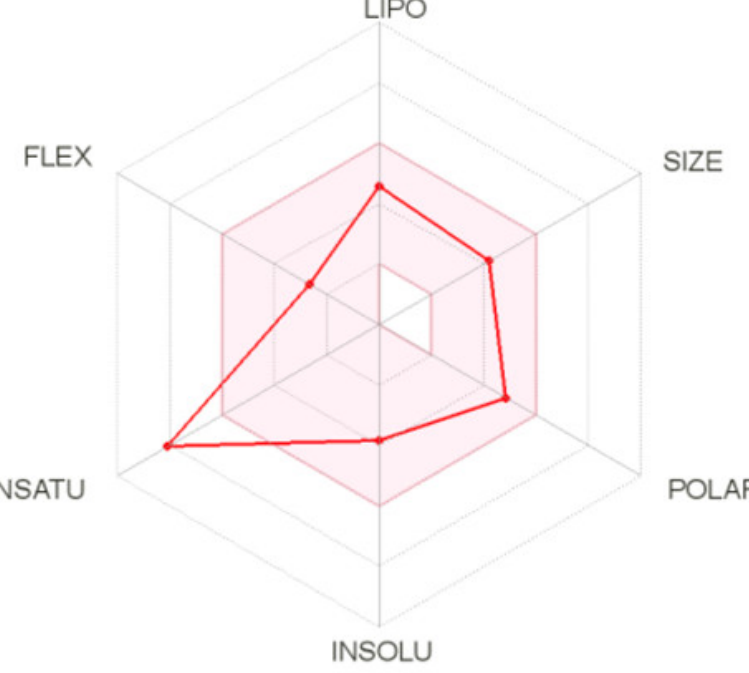
Figure 8. The bioavailability radar (the pink area exhibits the optimal range of a particular prop- erty) for compound 2C (LIPO = lipophilicity as in XLOGP3; SIZE = size as in molecular weight; POLAR = polarity as TPSA (topological polar surface area); INSOLU = insolubility in water by log S scale; INSATU = insaturation per fraction of carbons in the sp3 hybridization; FLEX = flexibility per rotatable bonds).